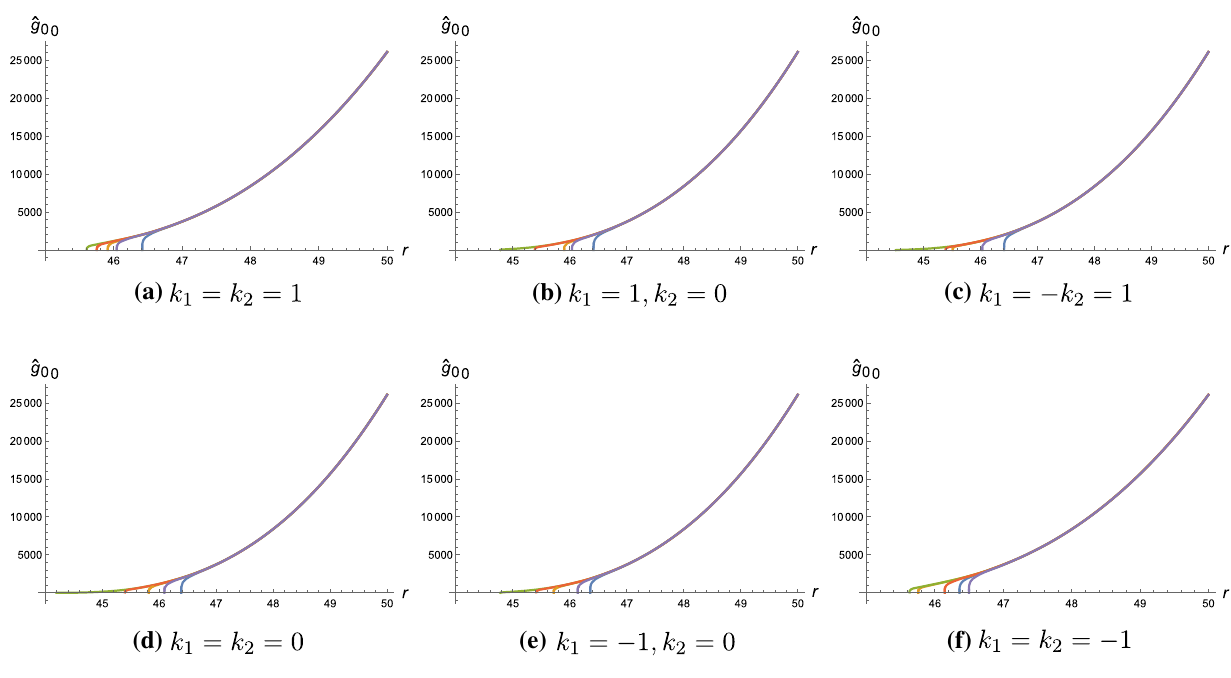
Fig. 44 Profiles of the ten-dimensional metric component ˆ g 00 for the supersymmetric flows given in Figs. 38, 39, 40, 41, 42, and 43